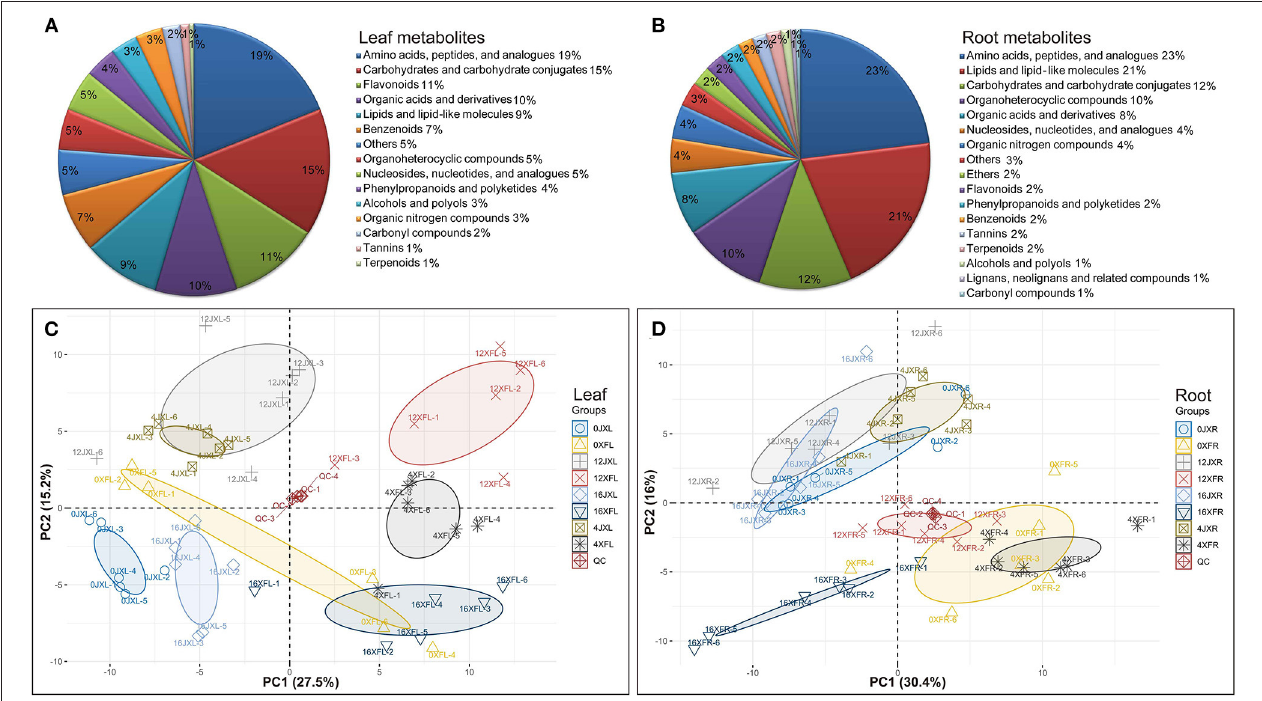
FIGURE 3 | The classification of 185 differential metabolites in leaves (A) and 165 differential metabolites in roots (B) . PCA score plot of tea samples based on the relative variation of the leaf metabolites (C) and root metabolites (D) detected by UHPLC-Q TOF MS using the leaves and roots harvested from two cultivars under shading. The legend (Group) describes the abbreviations for the unshaded “Xiangfeicui” leaves (0XFL), XFC leaves after 4 days of shading (4XFL), XFC leaves after 12 days of shading (12XFL), XFC leaves after 4 days of regaining light (16XFL), unshaded “Jinxuan” leaves (0JXL), JX leaves after 4 days of shading (4JXL), JX leaves after 12 days of shading (12JXL), JX leaves after 4 days of regaining light (16JXL); XFC roots when the plants were unshaded (0XFR), XFC roots after 4 days of shading (4XFR), XFC roots after 12 days of shading (12XFR), XFC roots after 4 days of regaining light (16XFR), JX roots when the plants were unshaded (0JXR), JX roots after 4 days of shading (4JXR), JX roots after 12 days of shading (12JXR), and JX roots after 4 days of regaining light (16JXR). Each sample has six biological replicates (1–6). QC represents quality